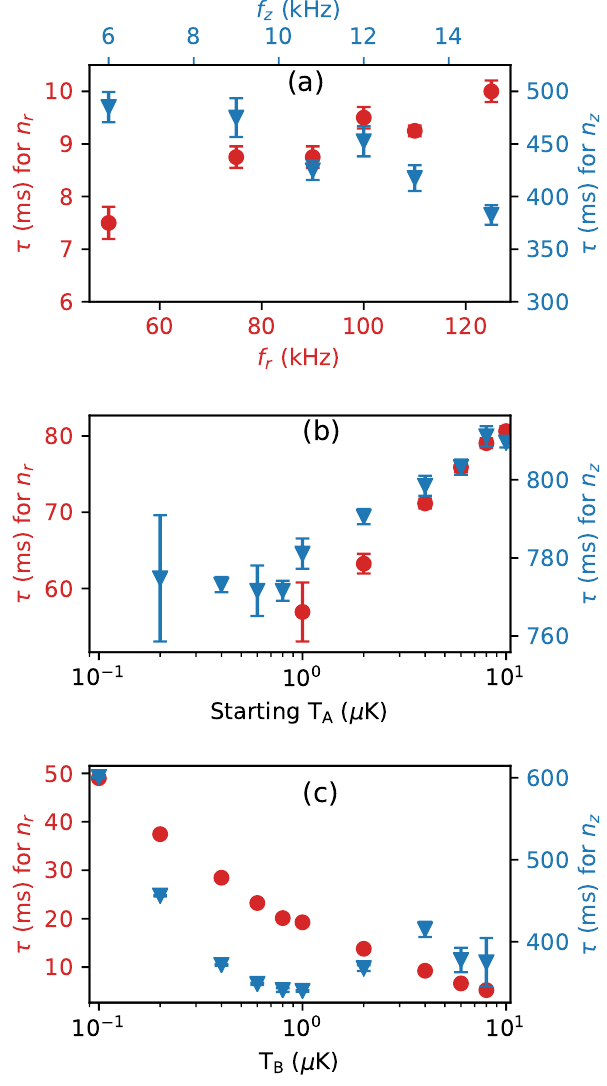
Figure 2. The variation of thermalization time constants of radial and axial vibrational levels of the trapped atom with respect to ( a ) the trapping frequency, ( b ) the starting temperature of the trapped atom, and ( c ) temperature of the bath. The red circles are for radial direction and the blue triangles are for the axial direction. Here a = 160 a 0 , n B = 7.7 × 10 12 cm − 3 , ω / ( 2 π ) = 100 kHz for ( b , c ), T B = 4 µ k, and T B = 0.1 µ k for ( a , b ) respectively. T A = 8 µ k and T A = 10 µ k for ( a , c ) respectively. For all the data points η y = 0.98 and η z =